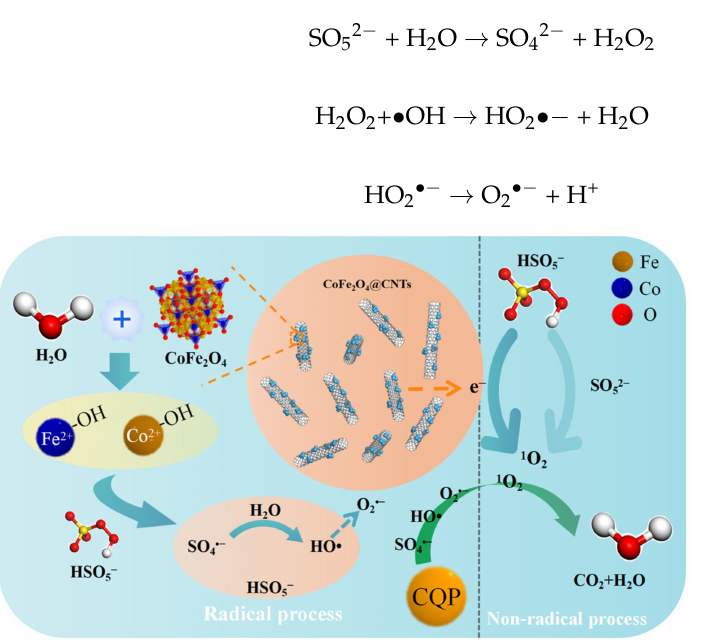
Figure 18. Reaction mechanism for the degradation of CQP in CoFe 2 O 4 @CNTs/PMS